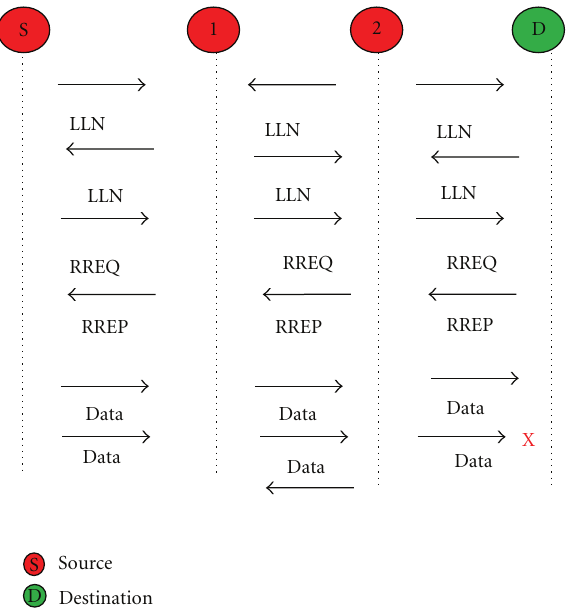
Figure 7: Message exchange in LOAD protocol